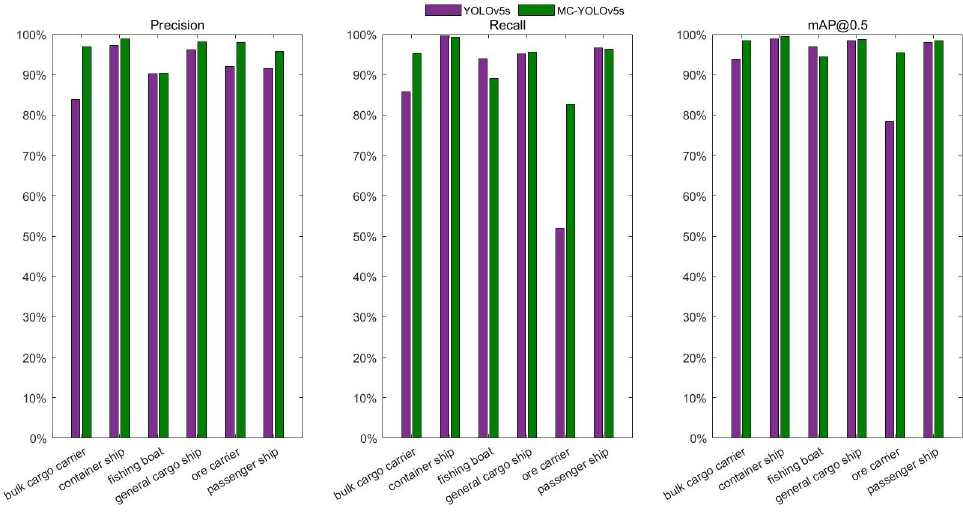
Fig 12. Test results for different types of ships.